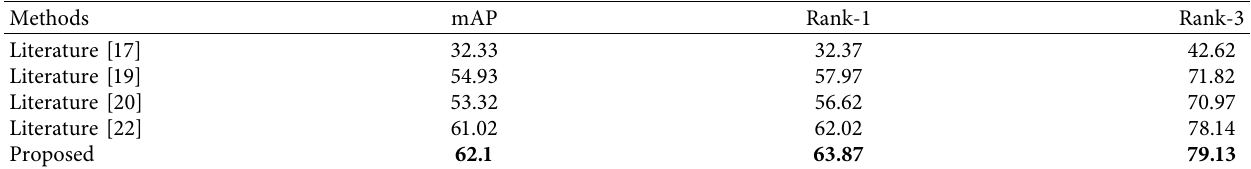
Table 3: The accuracy result on